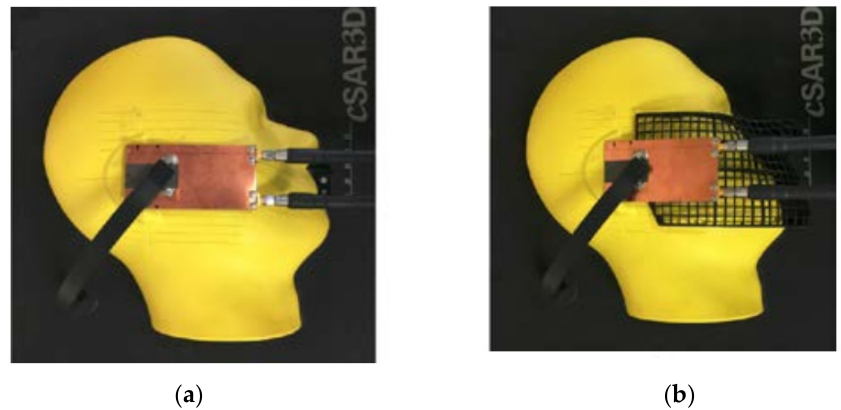
Figure 10. Two-port antenna board placed next to the c-SAR3D SAM phantom with ( a ) touch gesture and ( b ) 15 degree tilt gesture.